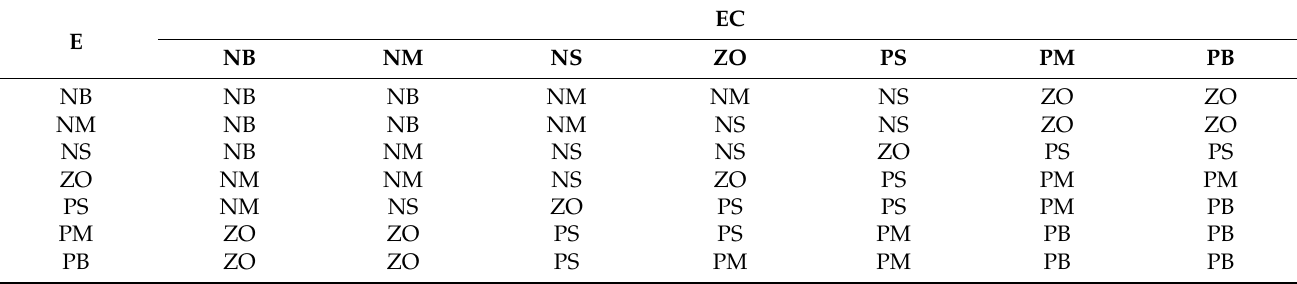
Table 2. The fuzzy control rules of integral coefficient.